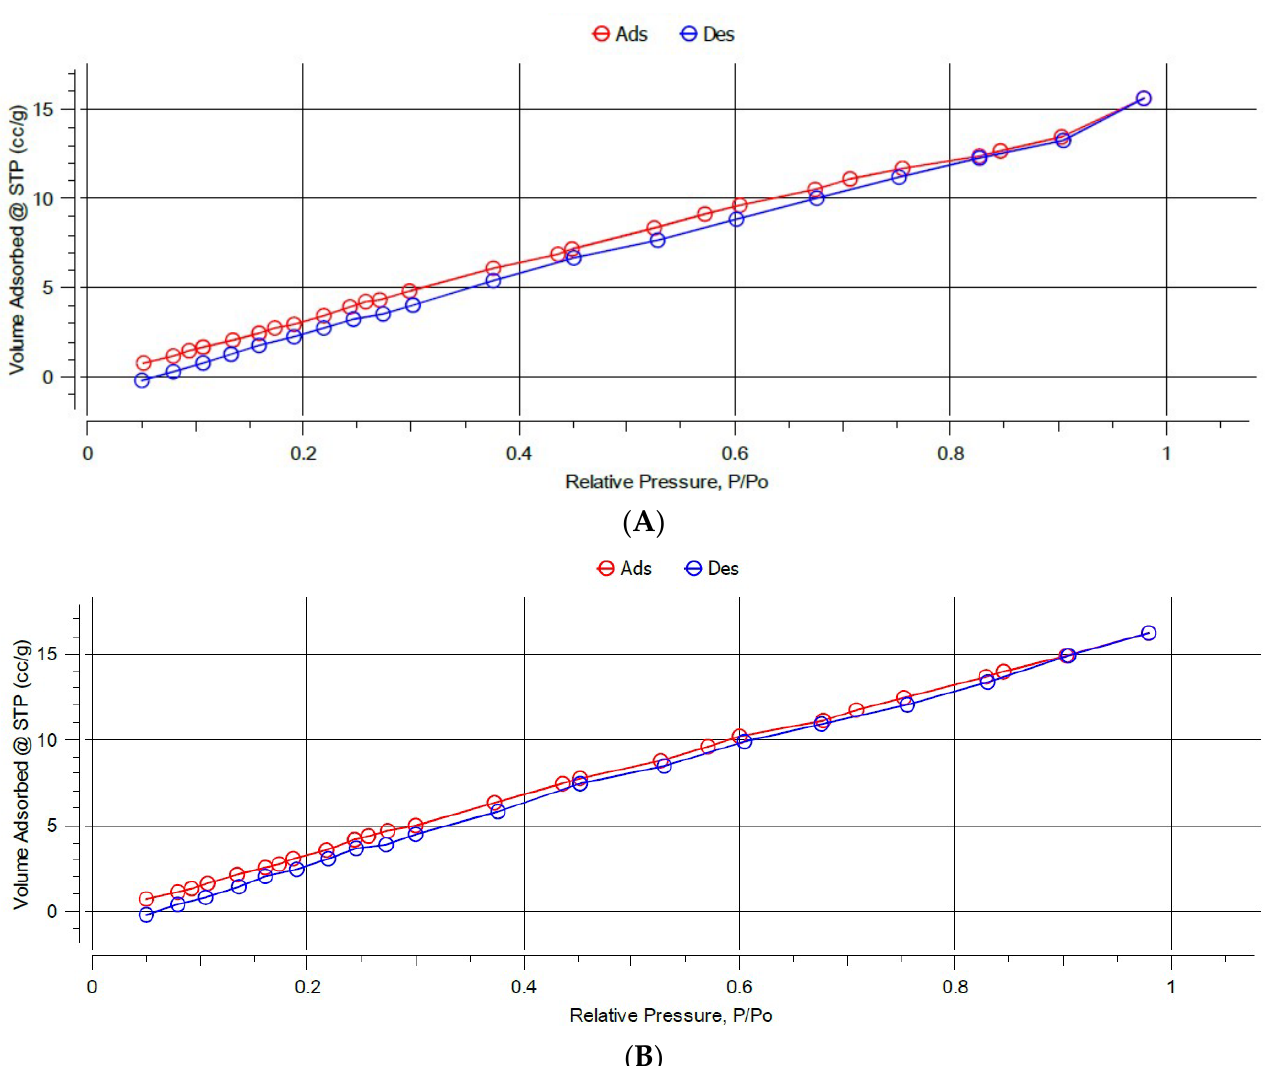
Figure 4. BET isotherms of ( A ) MIP C and ( B ) NIP C.